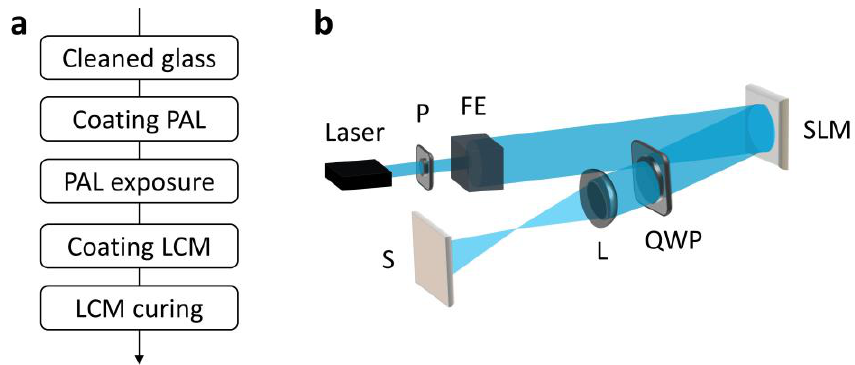
Figure 3. ( a ) LC Dammann grating fabrication workflow. ( b ) Exposure setup for recording the Dammann grating pattern on LC alignment layer. PAL: photo-alignment layer; LCM: liquid crystal mesogen; P: polarizer; FE: filtering and expansion; SLM: spatial light modulator; QWP: quarter-wave plate; L: lens; S: sample.